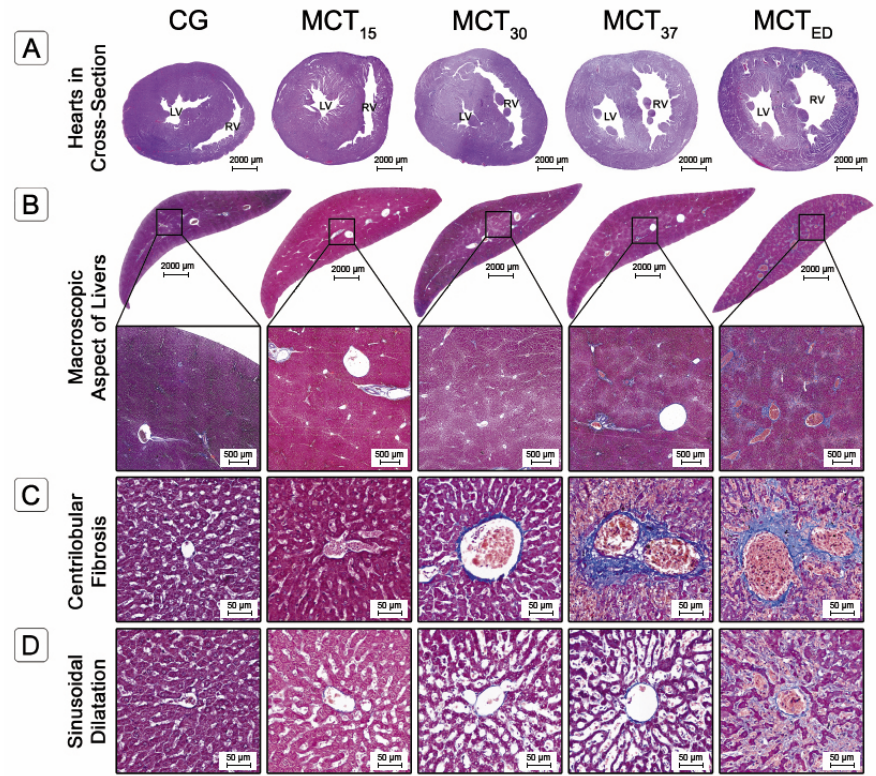
Figure 3. ( A ). Heart cross-section stained with hematoxylin-eosin of a CG animal and MCT-group animals (Hematoxylin-eosin stain). ( B ) Macroscopic aspect of livers stained with Masson trichrome. ( C , D ) Regions of interest (ROIs) of liver tissue sections stained with Masson trichrome of the CG animal and MCT-group animals, showing centrilobular fibrosis ( C ) and sinusoidal dilatation ( D ). LV, left ventricle; RV, right ventricle.